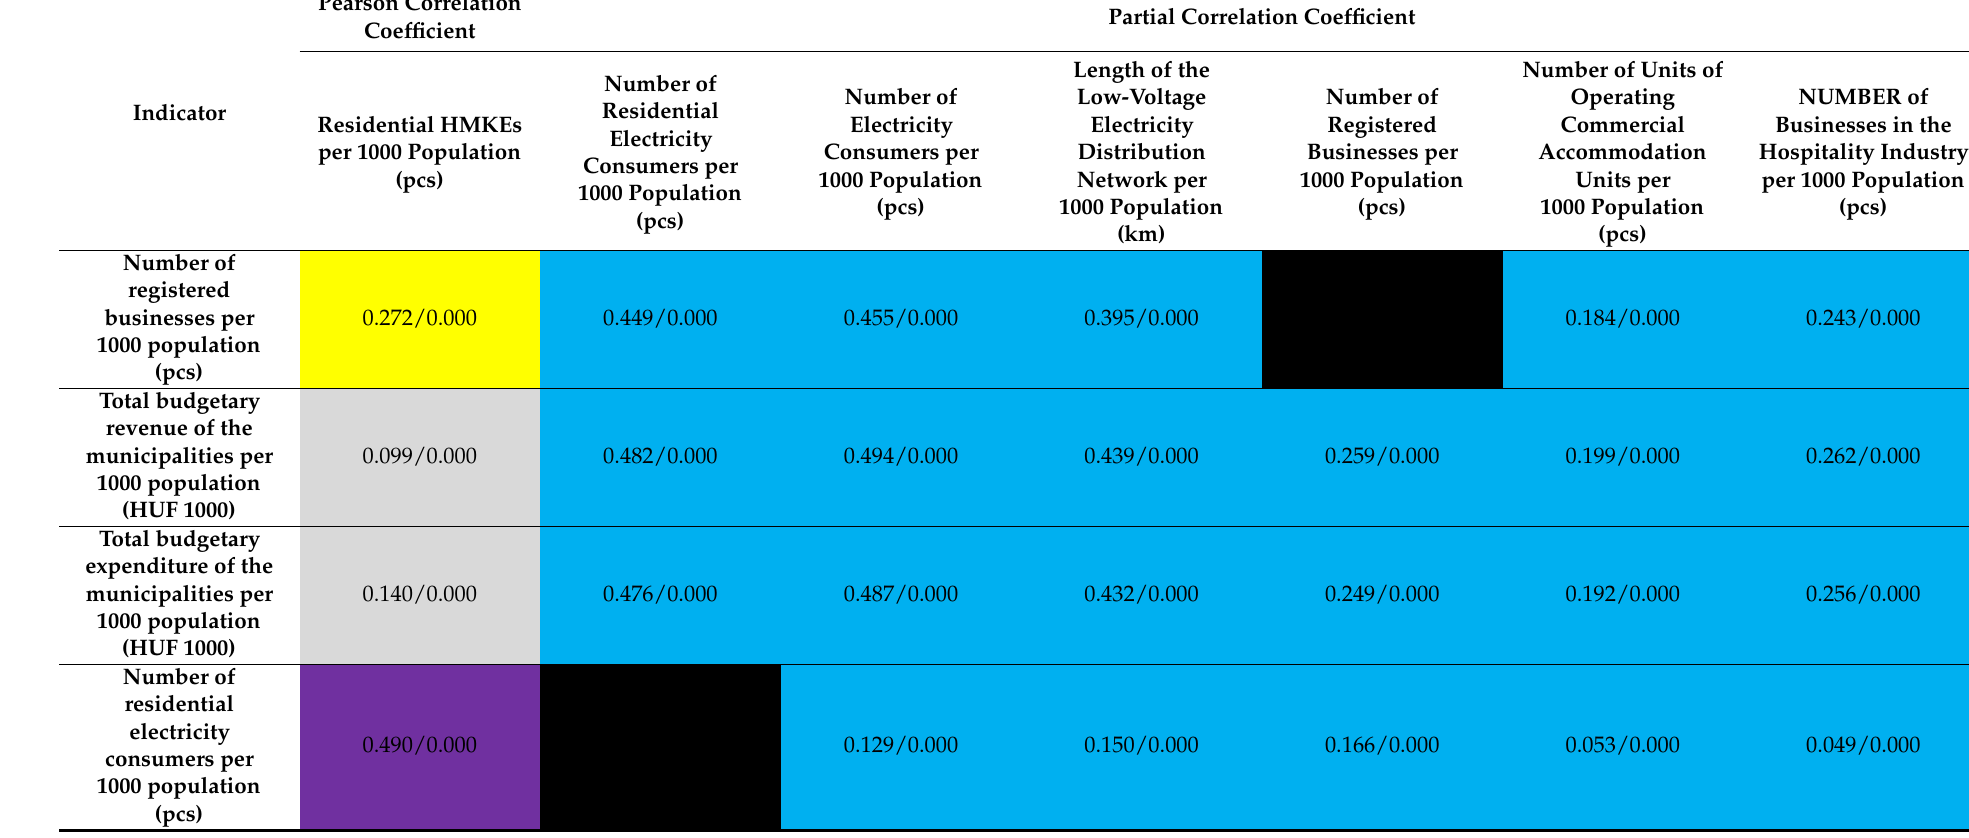
Table A1. The strengths of the relationships between the quantity of the residential HMKEs per 1000 population and the settlement indicators 1 ( 1 Pearson correlation coefficient/ p -value; if p < 0.05, then there is a significant verified relationship between the two variables) (In the case of the Pearson correlation coefficients in the table grey background indicates weak correlations, yellow means weak moderate, and purple moderately close ones. In the case of the partial correlation the blue background signals partial explanation (the controlled variable explains the relationship between variables i and j only partially), while the black one shows irrelevant